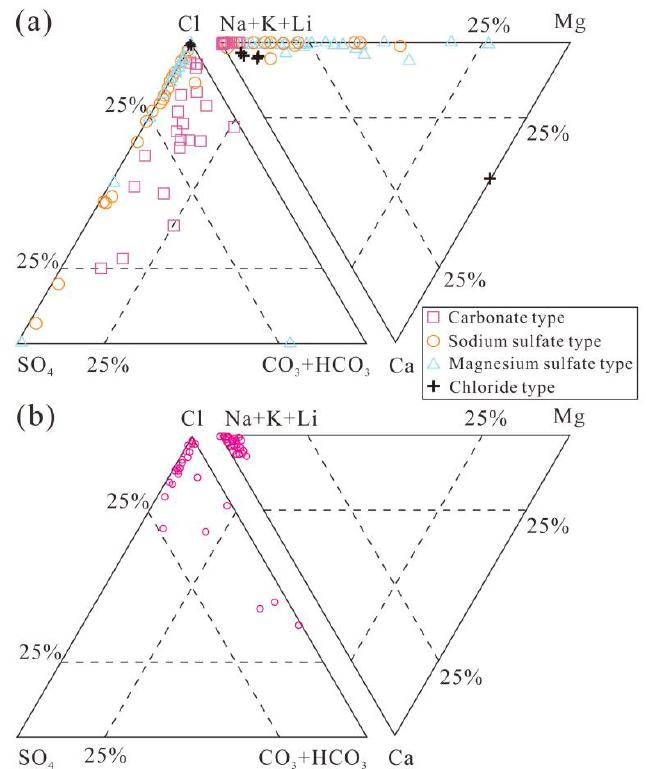
Figure 2. ( a ) Brine compositions of Li-rich salt lakes on the Qinghai-Tibetan Plateau; ( b ) brine compositions of Bolivian salars (from [42]). The data of salt lakes on the QTP can be seen in Table 1.